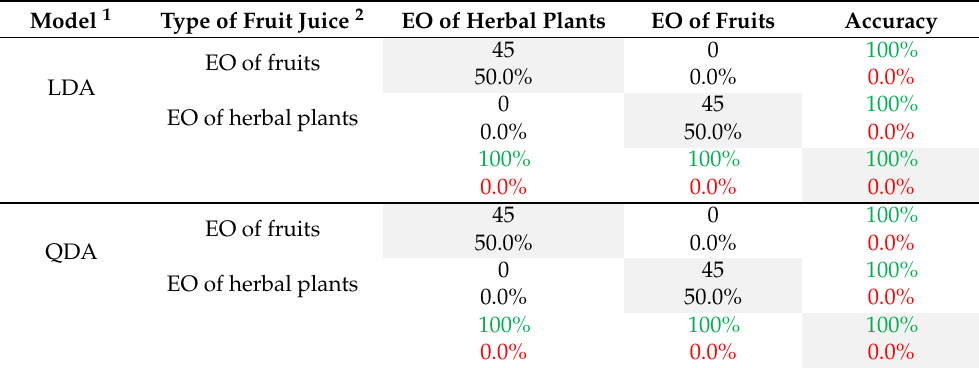
Table 2. Confusion matrix for two-group classification of herbal plant and fruit essential oil (EO) using LDA and QDA statistical